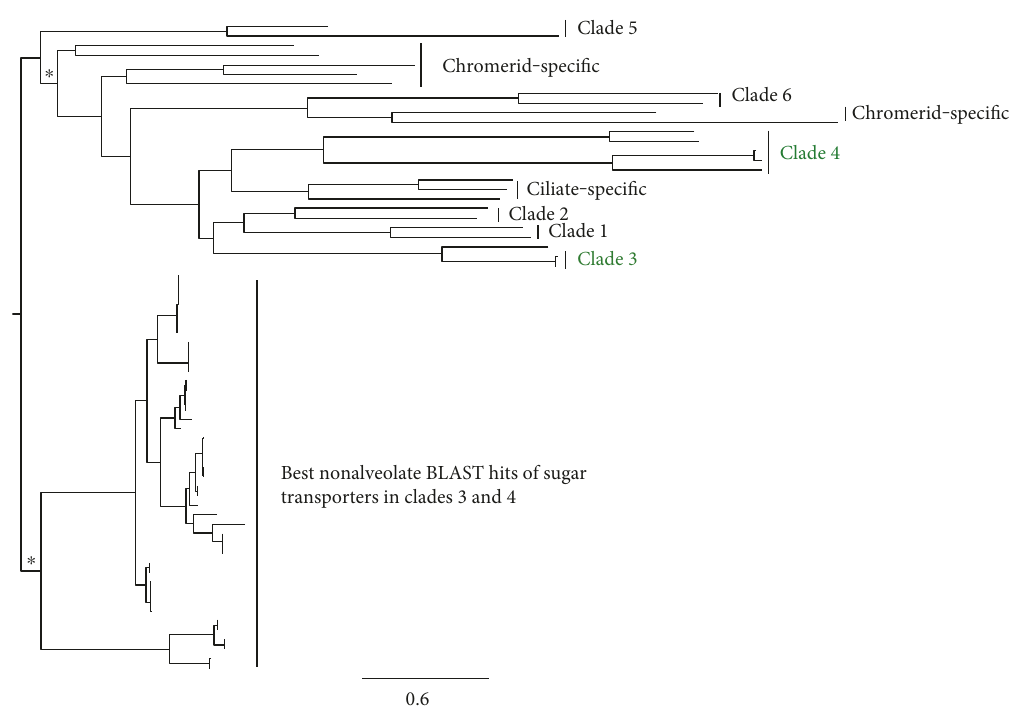
Figure 3: Expanded phylogeny of divergent Plasmodium and Cryptosporidium as well as representative sugar transporter member from across the tree of life. Representative sugar transporters from across the tree of life are included. Clades containing divergent sugar transporters identi fi ed in Figure 2 are colored green. Clade nomenclature according to Figure 1. BLAST hits are for sugar transporters in clades 3 and 4. Asterisk represents at least 95%